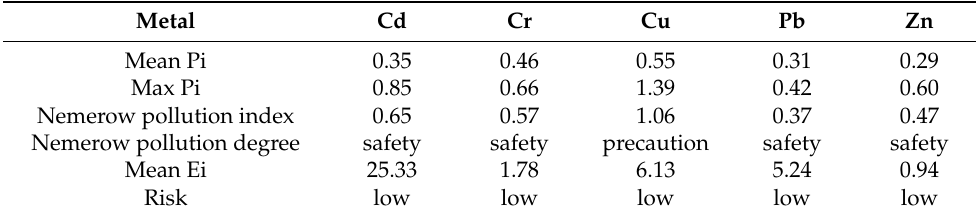
Table 7. Pollution degree and potential ecological risk of heavy metals in the study area.